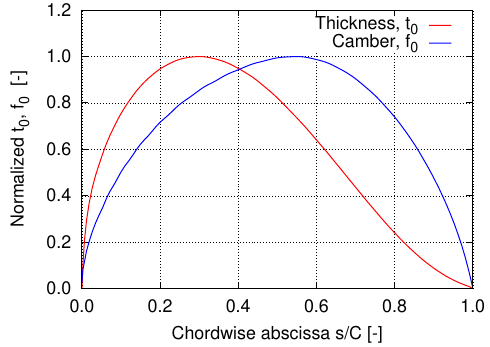
Fig. 7. Model turbine: Worthmann FX normalized thickness and camber chordwise